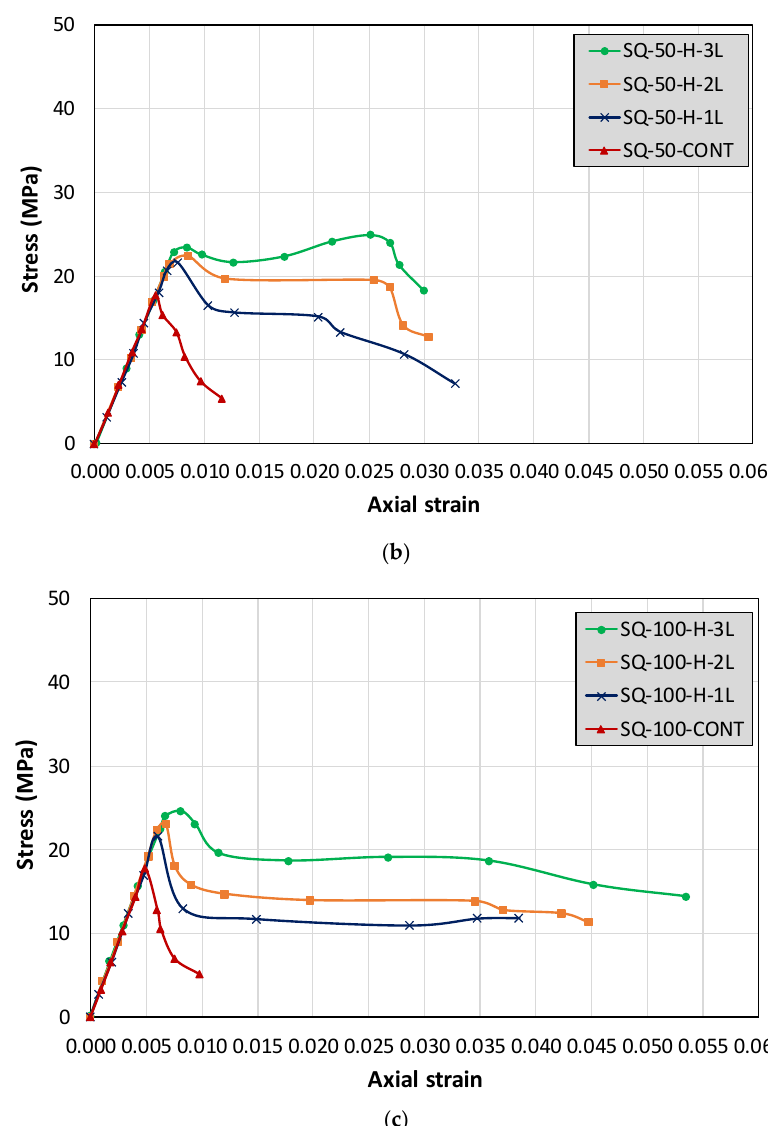
Figure 6. Axial compressive stress–strain relationships ( a ) group 1, ( b ) group 2, and ( c ) group 3.